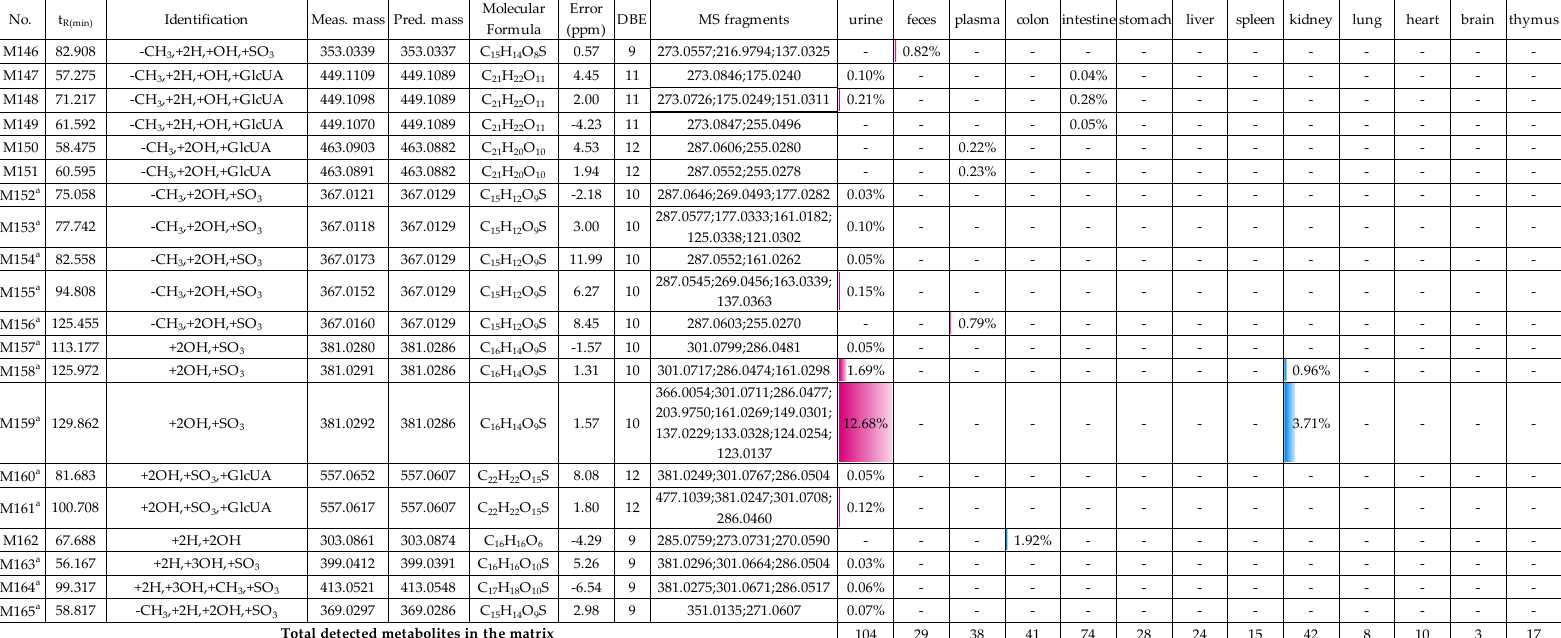
Figure 14. The distribution of 165 metabolites of medicarpin and their relative contents in 13 biosamples ( a , new compounds). The relative content of a metabolite in each biosample was calculated by (peak area of a metabolite/total peak area of all detected metabolites) × 100%.